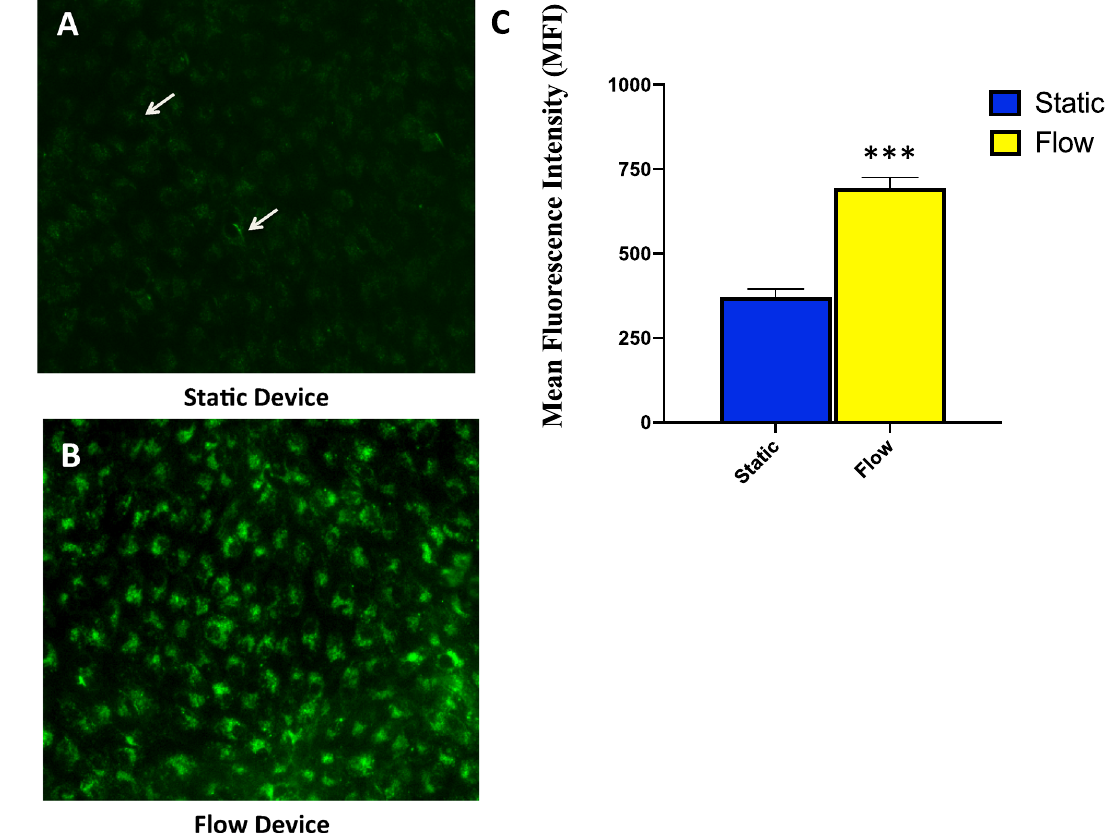
Figure 6. Analysis of human proximal tubular albumin reuptake function. Albumin uptake by human proximal tubular epithelial cells after 15 min incubation at 37 °C with 50 µg mL-1 of FITC-albumin (green) added to the channel under static conditions ( A ) and fluid shear stress conditions ( B ). Mean Fluorescence Intensity (MFI) of RPTEC/TERT1 cells 24 h after static conditions versus fluid shear stress conditions showing a significant increase in FITC-Albumin fluorescence signal ( C ) (***p ≤ 0.001). Transcriptome profiling provides insight to differentially expressed genes corresponding to endocytosis process. Gene Symbol padj